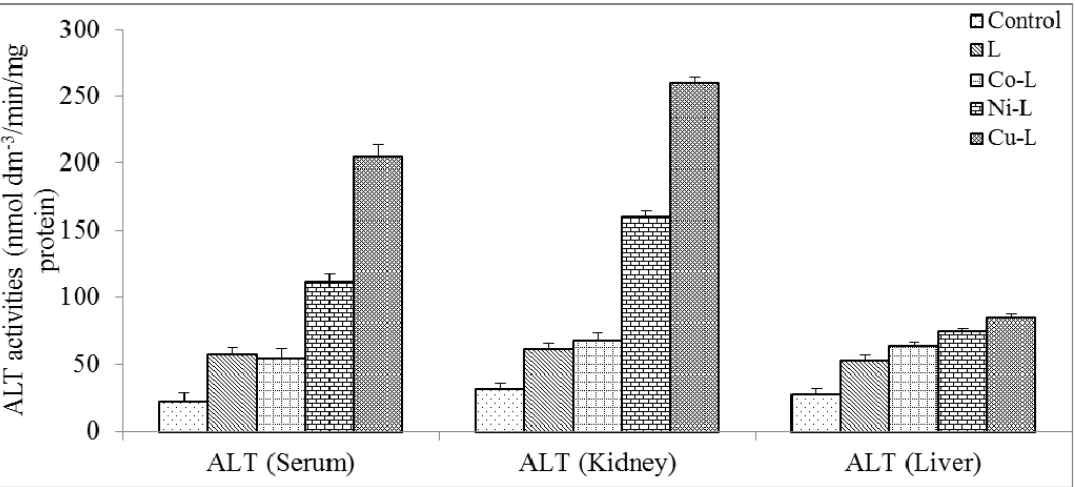
Figure 5. Effect of administration of ligand and the metal complex on the activities of alanine amino transferase (ALT) of rat serum, kidney and liver. * Significantly different from the control (p <